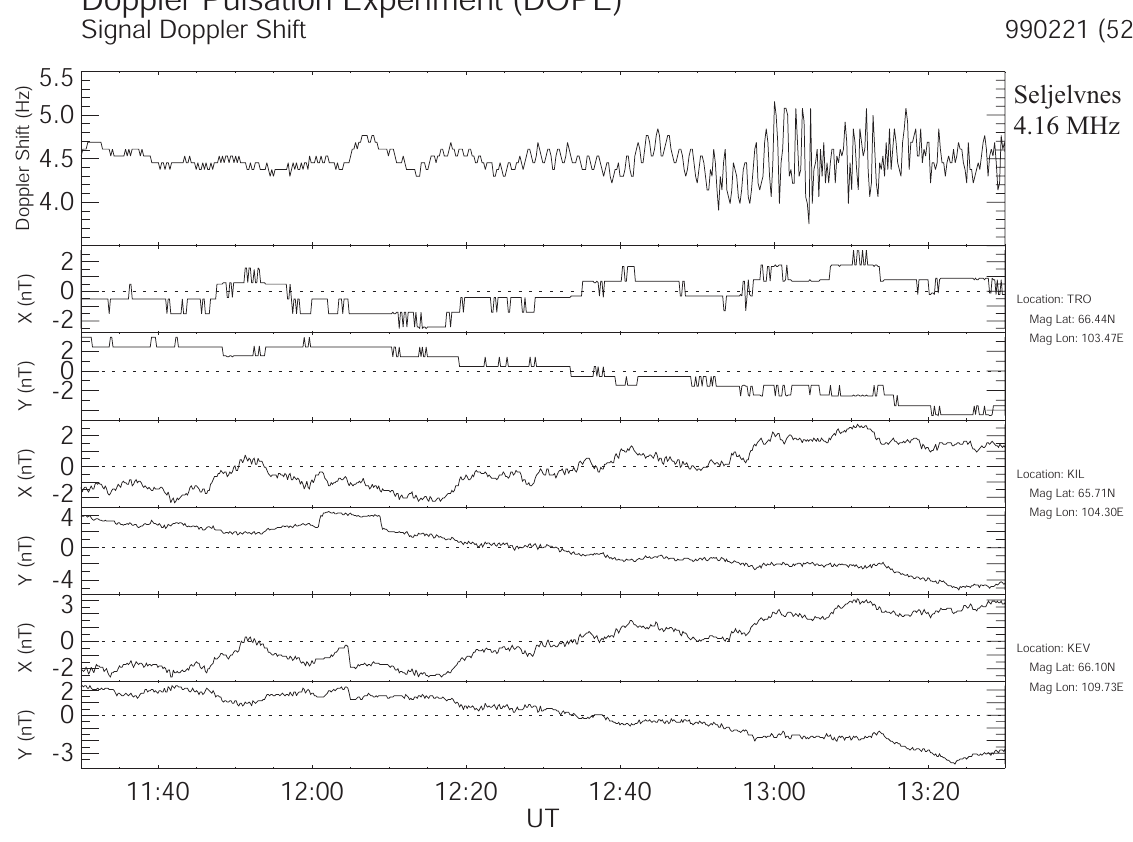
Figure 3. Fig. 3. A DOPE trace (Seljelvnes trace from Fig. 2d) and also magnetometer data from the IMAGE network. This wave event is classified as uncorrelated as there is no magnetic ground signature.